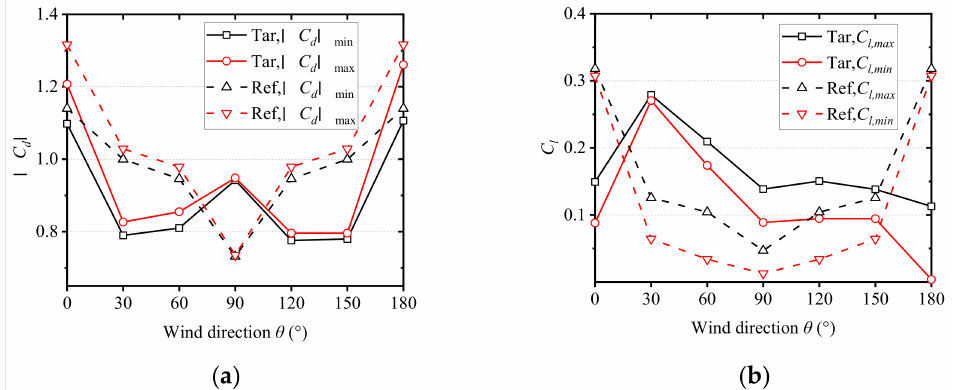
Figure 15. ( a ) Variation of drag coefficient | C d | with wind direction; ( b ) Variation of lift coefficient C l with wind